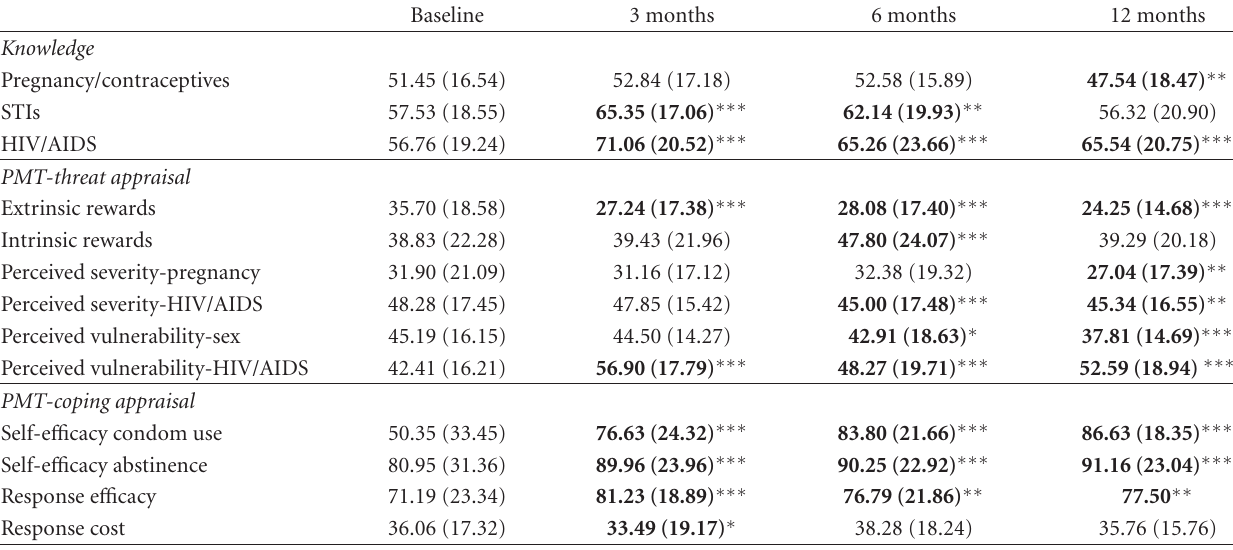
Table 2: Standard mean scores (with standard deviation) (range 0–100) for knowledge and PMT constructions at baseline and followups for VFOK a .